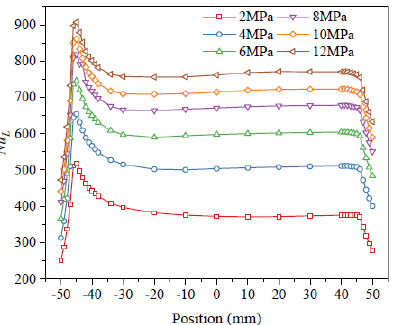
Figure 11. Variation of the local Nusselt number on the surface of the heating